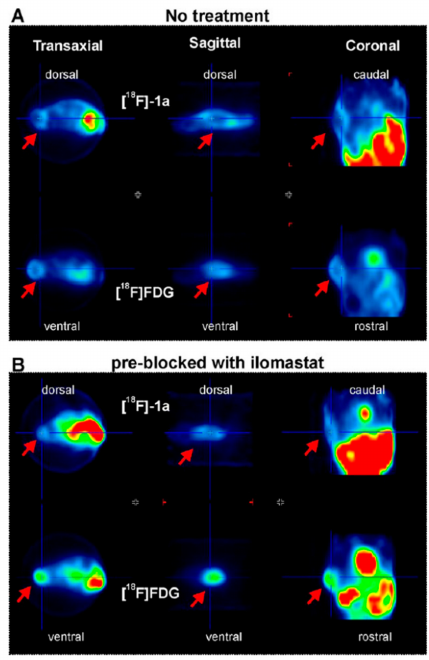
Figure 3. 18 F PET images of the abdomen of nude mice subcutaneously grafted with a human U-87 MG glioblastoma. Red arrows show the tumor in di ff erent slices. ( A ) PET images obtained by sequential administration of [ 18 F] 40 ( 1a ) (upper row) and [ 18 F]FDG (bottom row), showing colocalization of tracer uptake. The [ 18 F] 40 ( 1a ) scan was acquired 100 min post-tracer injection; [ 18 F]FDG was injected immediately after completion of the [ 18 F] 40 ( 1a ) scan and the image was acquired 45 min post-[ 18 F]FDG injection. Both scans were static acquisitions (injected dose 7.4 MBq, acquisition time 30 min). ( B ) PET images obtained by sequential administration of [ 18 F] 40 ( 1a ) (upper row) and [ 18 F]FDG (bottom row), in a mouse that received 40 mg / kg of the broad-spectrum MMPI Ilomastat 30 min before injection of [ 18 F] 40 ( 1a ). The timing scheme and injected doses are the same as in panel A. Reprinted with permission form [83] Copyright © 2013 American Chemical